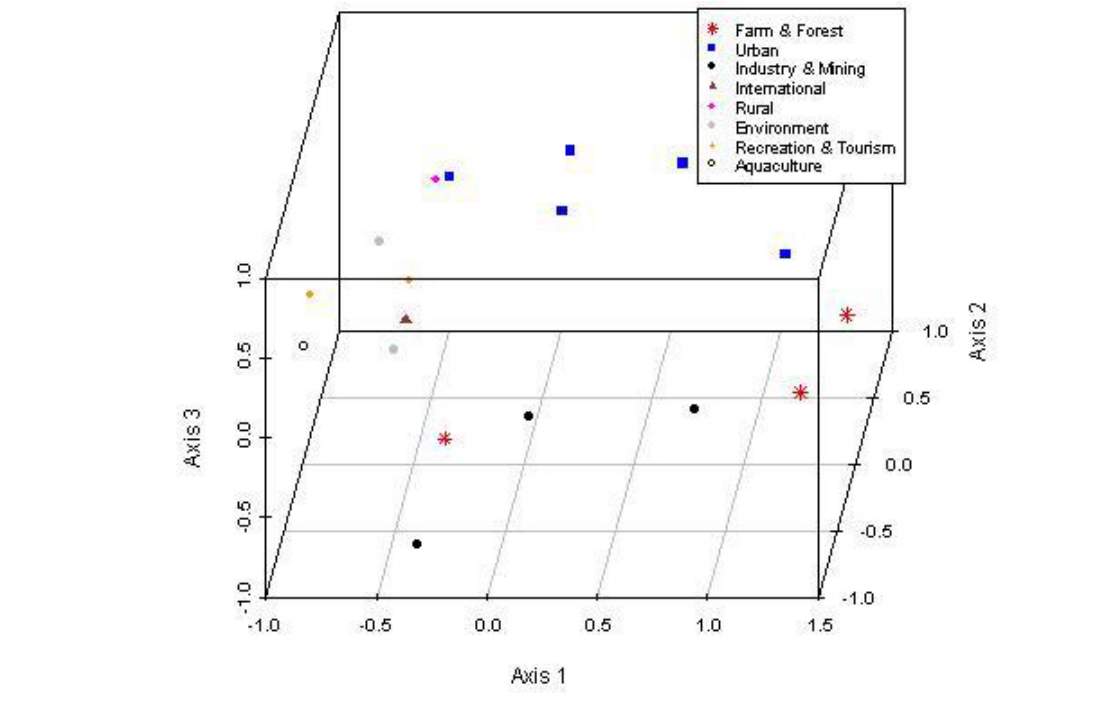
Fig. 4 . A three-dimensional MDS map of similarities among major users of the Crocodile River catchment, as identified by irrigators and conservationists (stress =